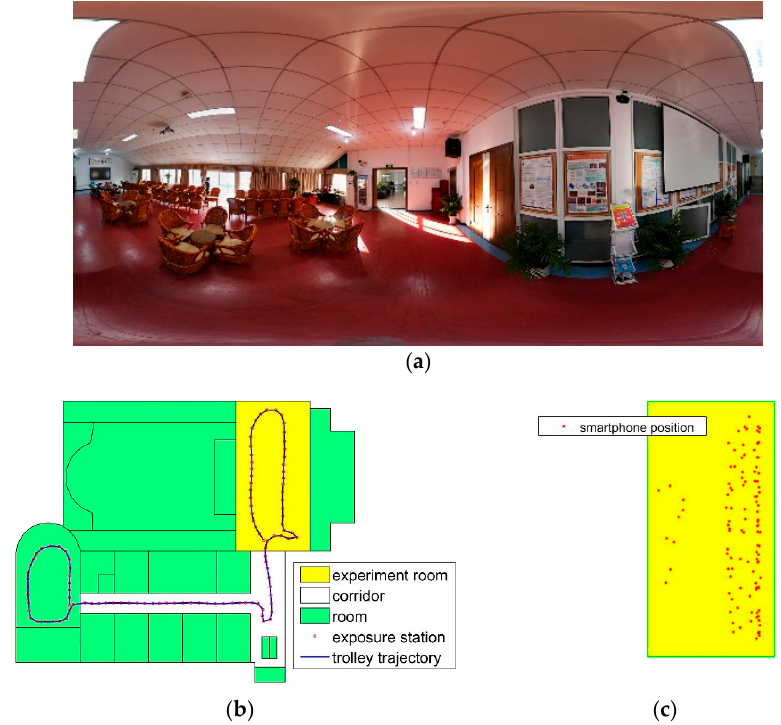
Figure 12. Data description in a challenging scene. ( a ) Panorama image of the room. ( b ) Database image data description. ( c ) The smartphone positions in the experiment room.